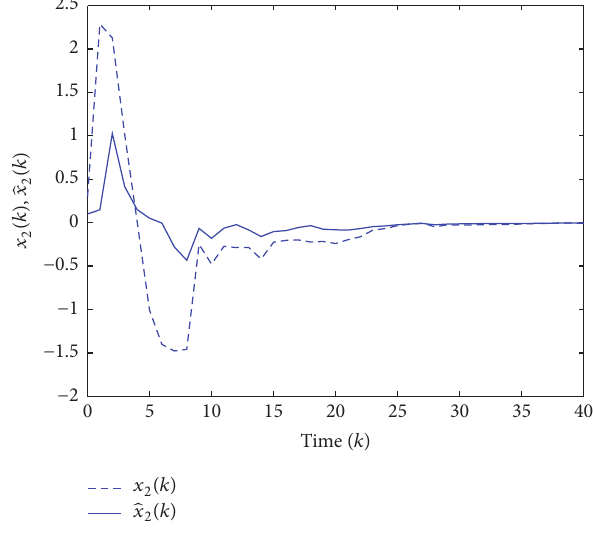
Figure 4: 𝑥 2 (𝑘) and its estimate ̂𝑥 2 (𝑘) .